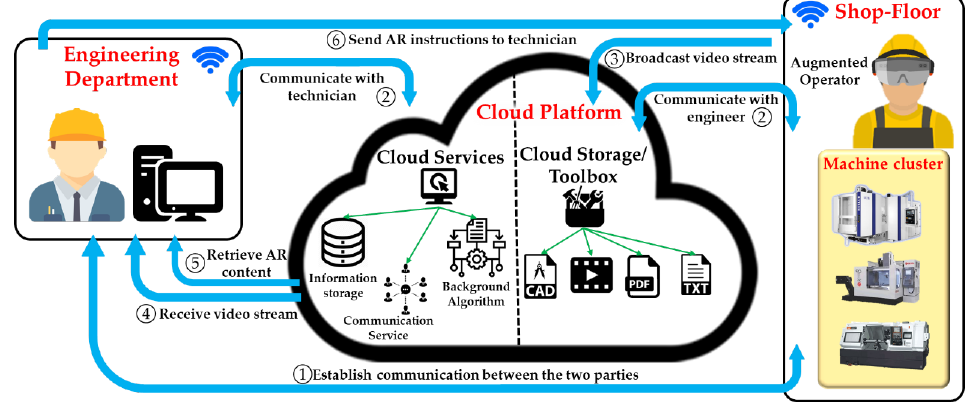
Figure 2. Proposed system architecture and steps sequence.